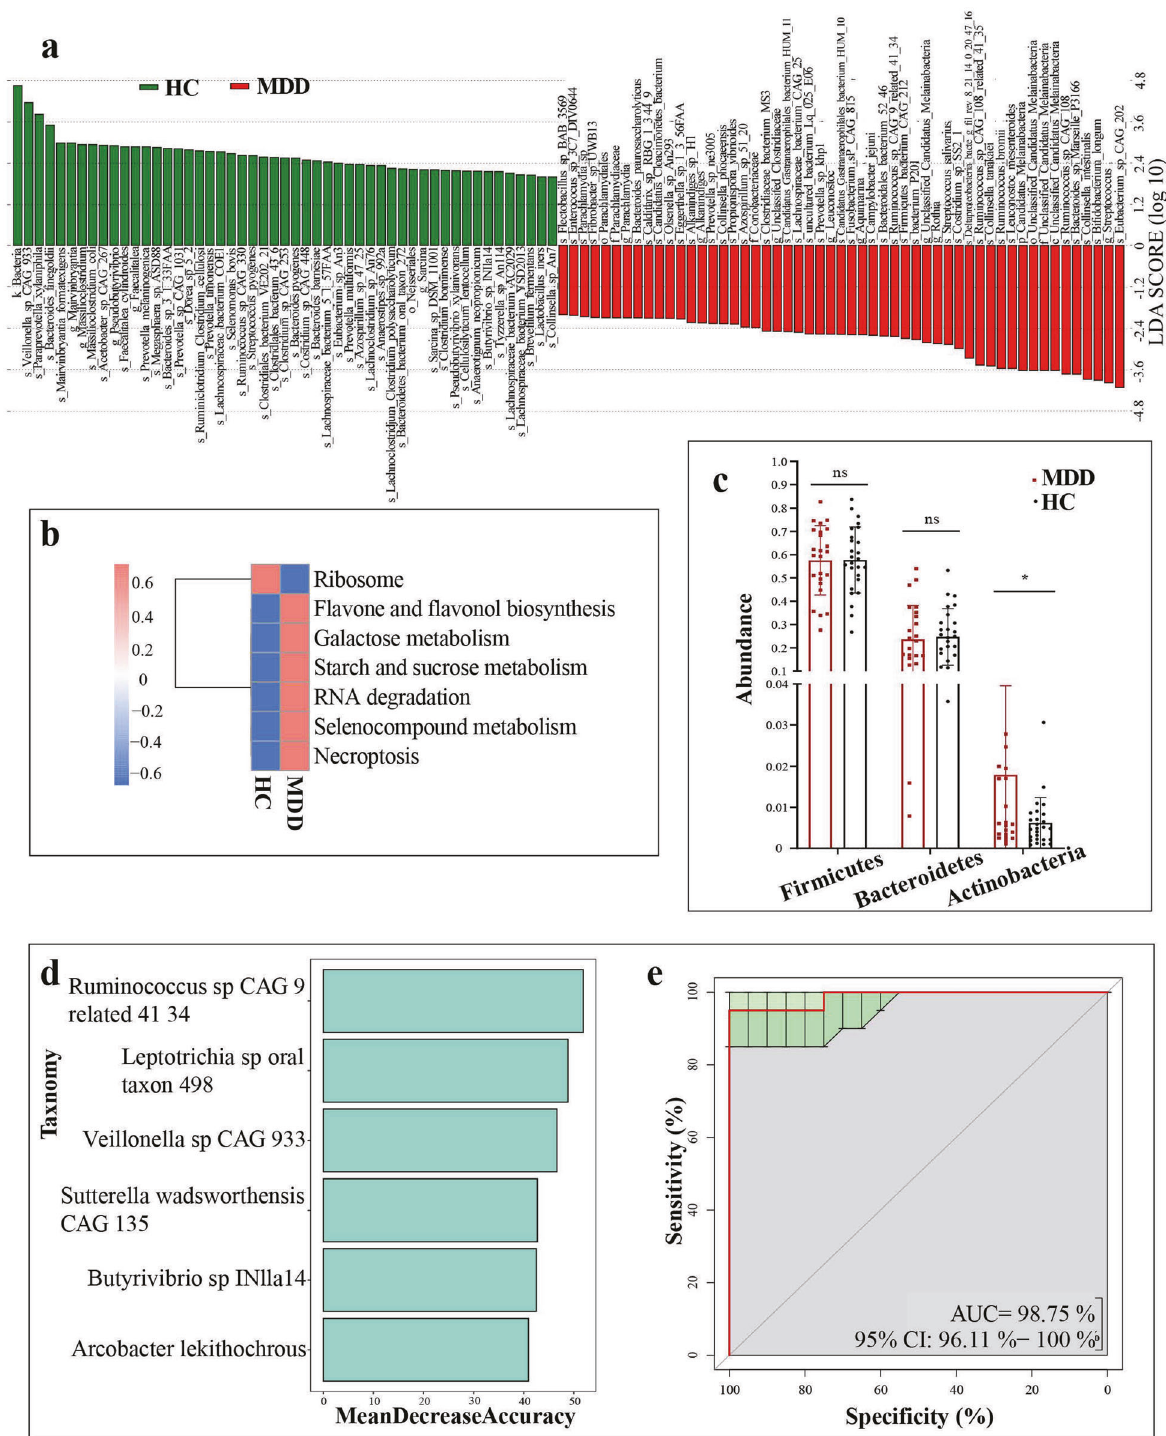
Fig. 2 Alterations of gut microbiota in MDD patients. a LDA scores revealed different composition in bacterial taxa between MDD and HCs (LDA = 2). Red bars indicate taxa were enrichment in MDD, and green bars represent abundant bacterial taxa in HCs. b Differential biological processes of gut microbiome function in MDD groups (red) relative to HCs (blue). c At the phylum level, the abundance of Firmicutes and Bacteroidetes were decreased in the MDD group relative to HCs, while Actinobacteria were signi fi cantly higher in the MDD group than in the HC group. ns: p > 0.05; * p < 0.05. d – e Using random forest models to predicted MDD diagnosis through biomarkers. b Six Biomarkers were screened according to Mean Decrease Accuracy in random forest. Rank the species from top to bottom according to their degree of contribution. c Receiver operating characteristic (ROC) curves of response predicted by random forest models. The area under the ROC curve (AUC) was 0.98 (95% CI: 0.961 – 1).